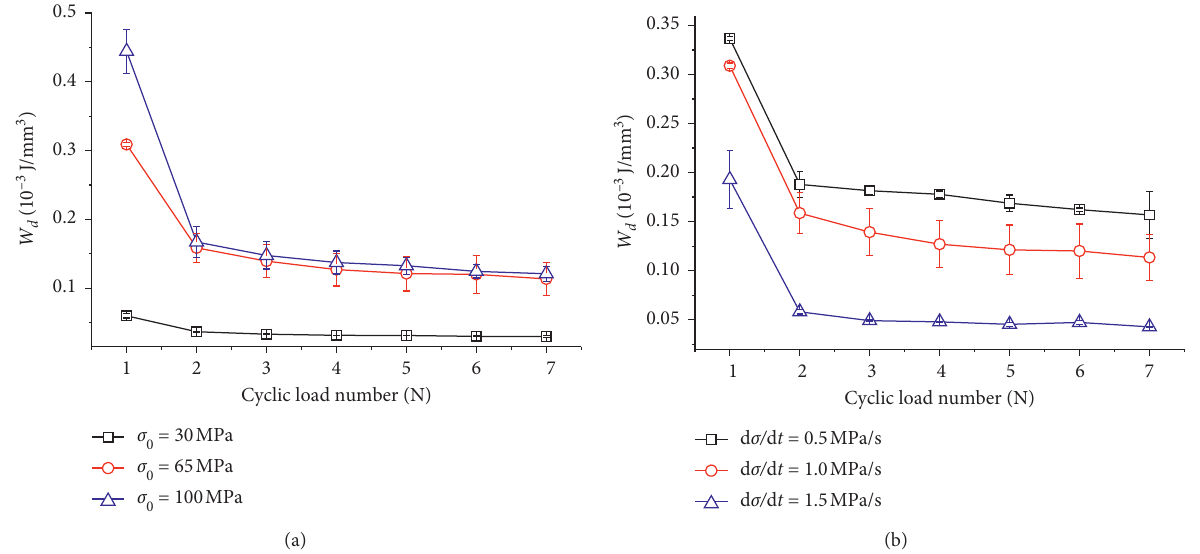
Figure 5: Dissipated energy per unit volume versus with the number of cycles. (a) d σ /d t � 1.0MPa, and (b) σ